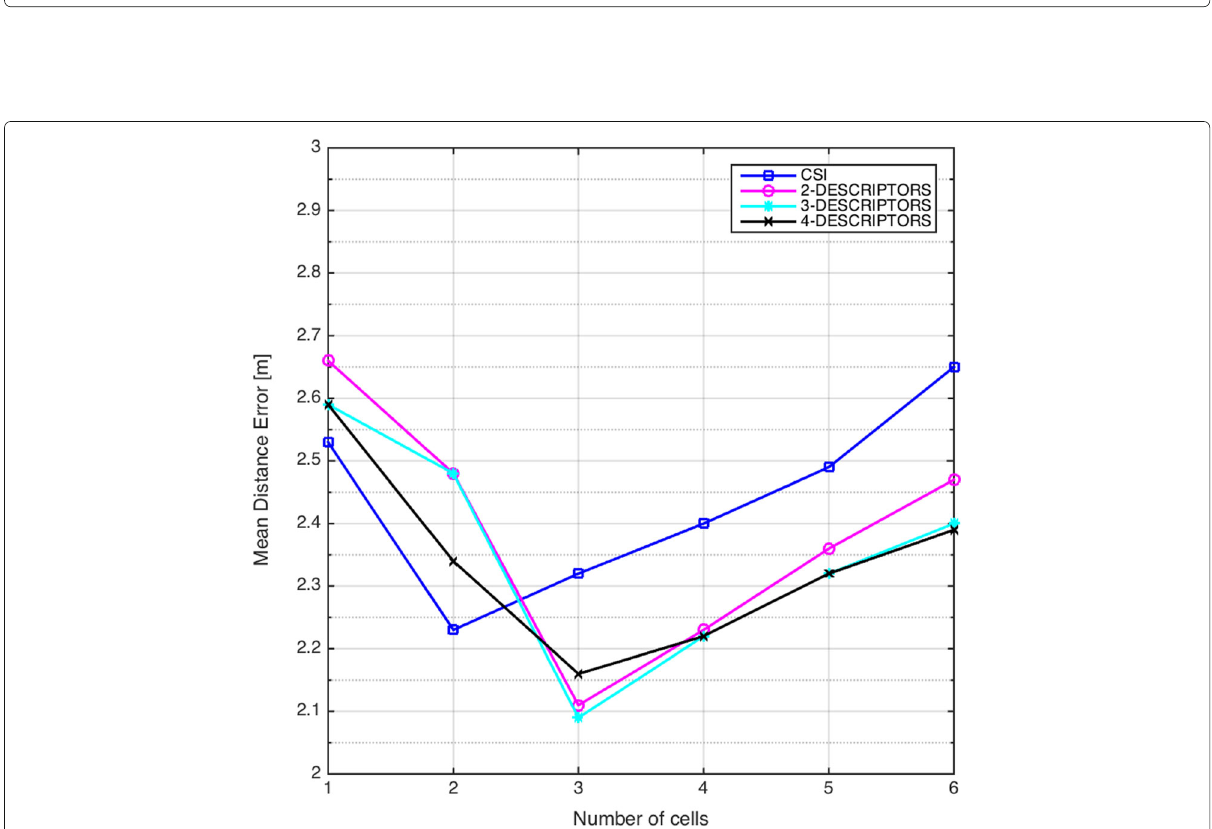
Fig. 10 Effect of cell diversity on localization performance. Mean Distance Error vs the number of cells used in the fingerprinting method for approaches based on CSI and on RSRP/CSI